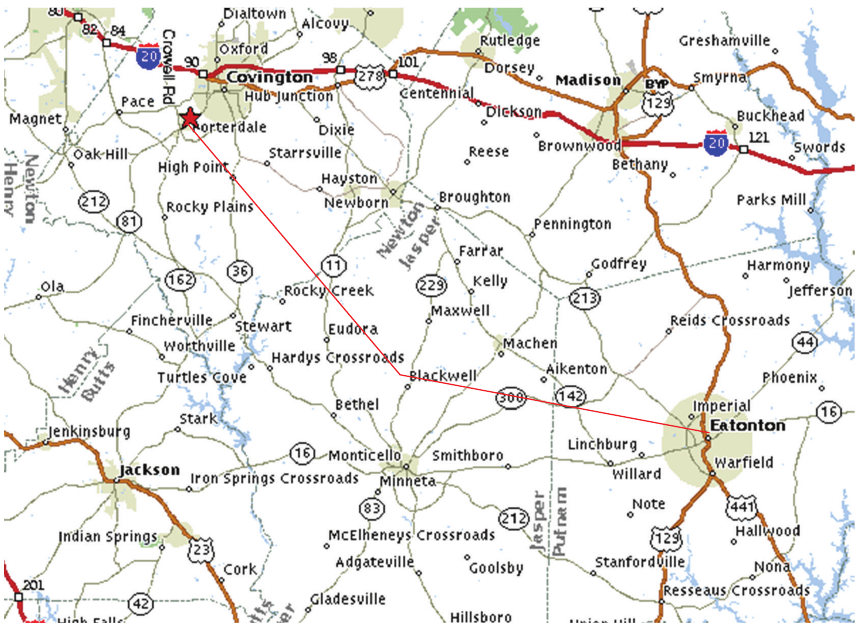
Figure 10: Validation project site in Georgia,